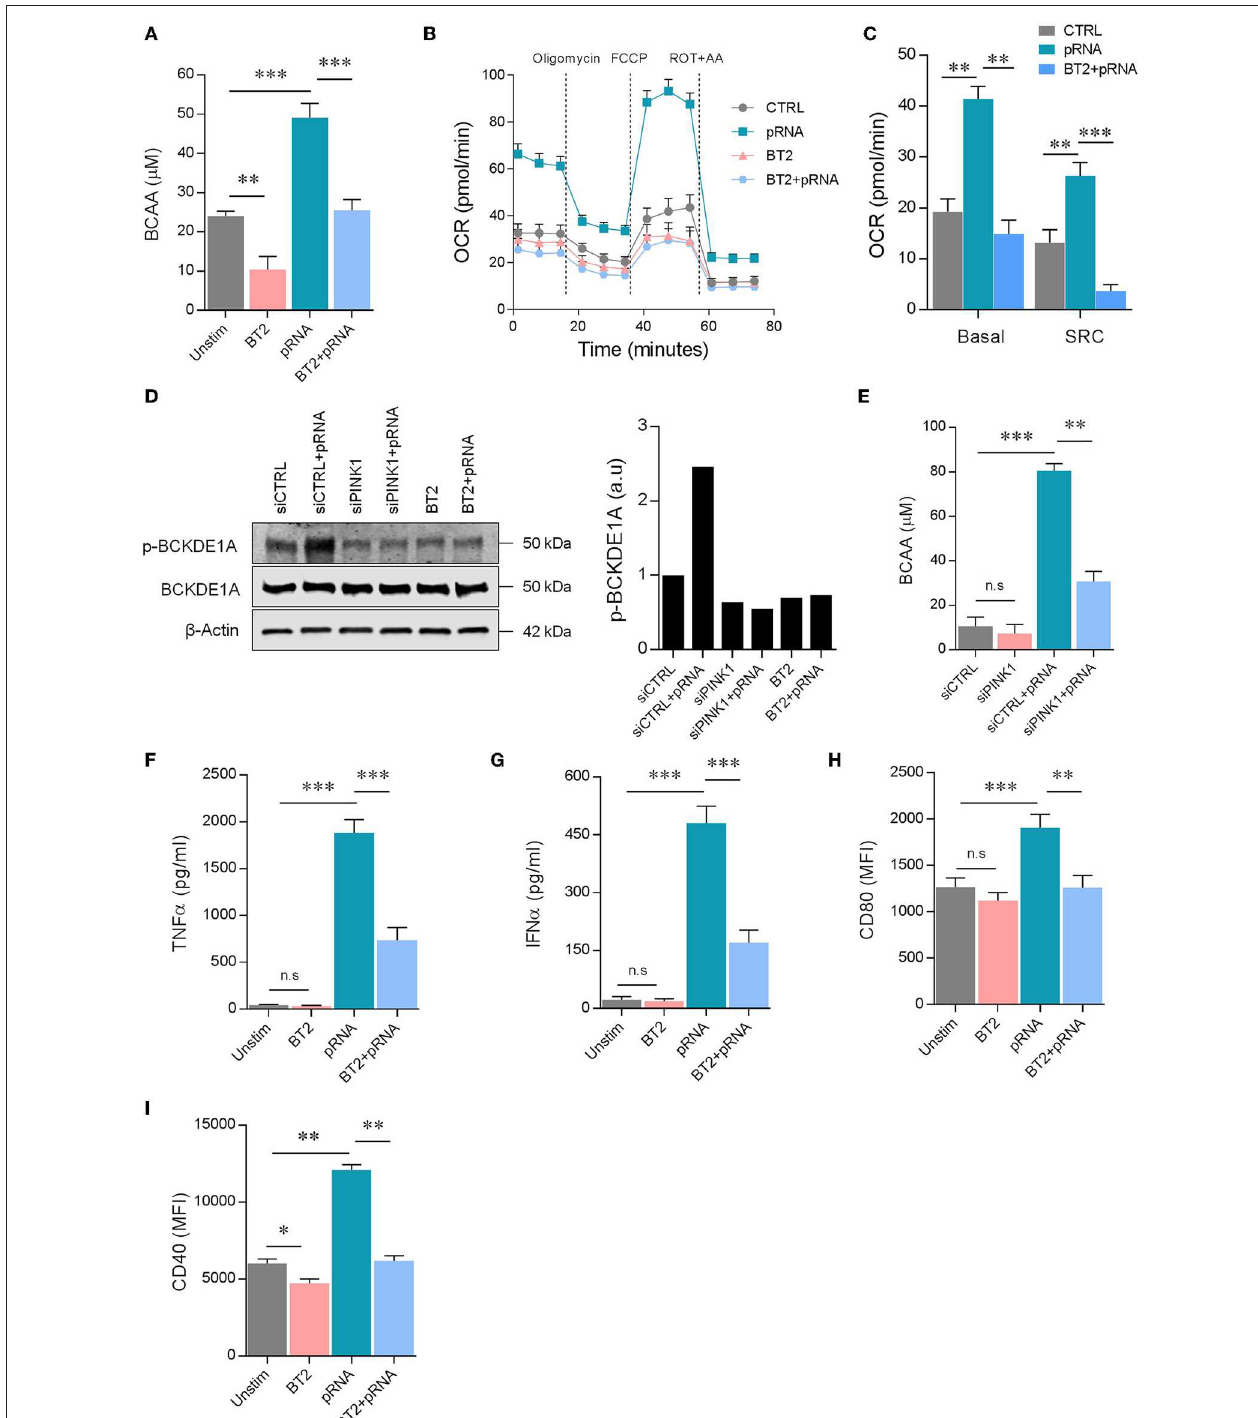
FIGURE 5 | PINK1 regulated BCAAs induce FAO in pRNA-stimulated DC. (A) Total BCAA concentrations were measured in the DCs stimulated for 12h with pRNA in the presence or absence of 50 µ M BT2, using a colorimetric assay kit. Data represents Mean ± SEM of three independent experiments performed in triplicate. ** p < 0.01; *** p < 0.001 (Student’s t -test). (B) OCR was measured in DC cultured in substrate-limited medium in the presence or absence of 50 µ M BT2. Quantification of total FAO as the difference between conditions with or without Etomoxir treatment is shown. Data represents mean ± SEM of three independent experiments performed in triplicate. (C) Data was collected within same experiments as (B) , but is shown separately for better understanding. Data represents mean ± SEM of three independent experiments performed in triplicate. ** p < 0.01; *** p < 0.001 (Student’s t -test). (D) Protein levels of phosphorylated p-BCKDE1 α and total BCKDE1